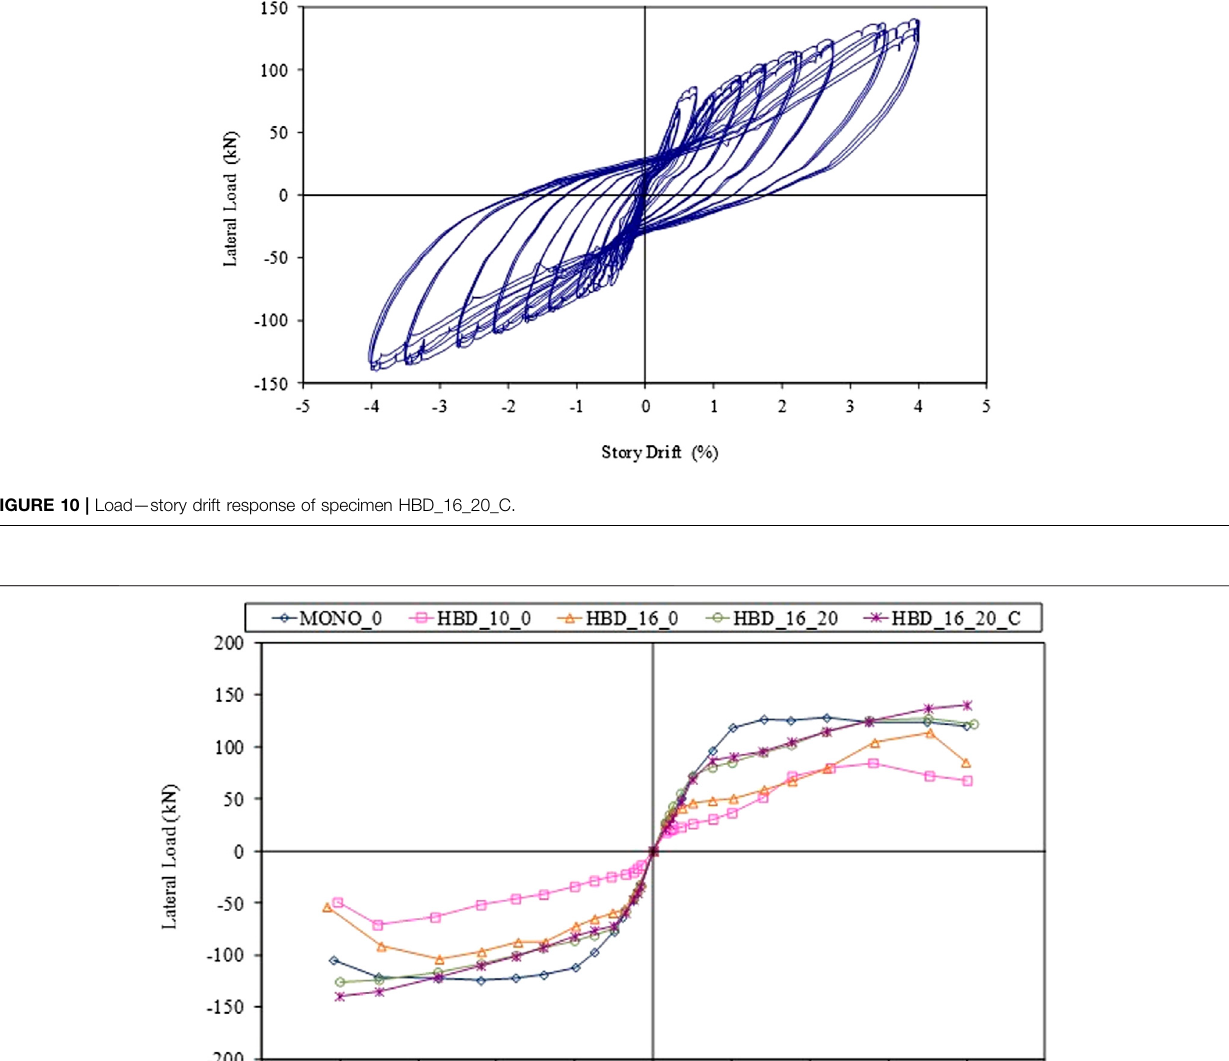
Figure 10 . Maximum measured push load was 140 kN while the pull capacity was − 140 kN. Maximum tension force measured in the post tensioning bolts was 1,055 MPa (Force is 299 kN) at the 4.00% cycle. The opening at the beam-column interface reached a maximum level of 17.3 mm. Vertical relative sliding at the beam- column interface minimized with the help of steel brackets.